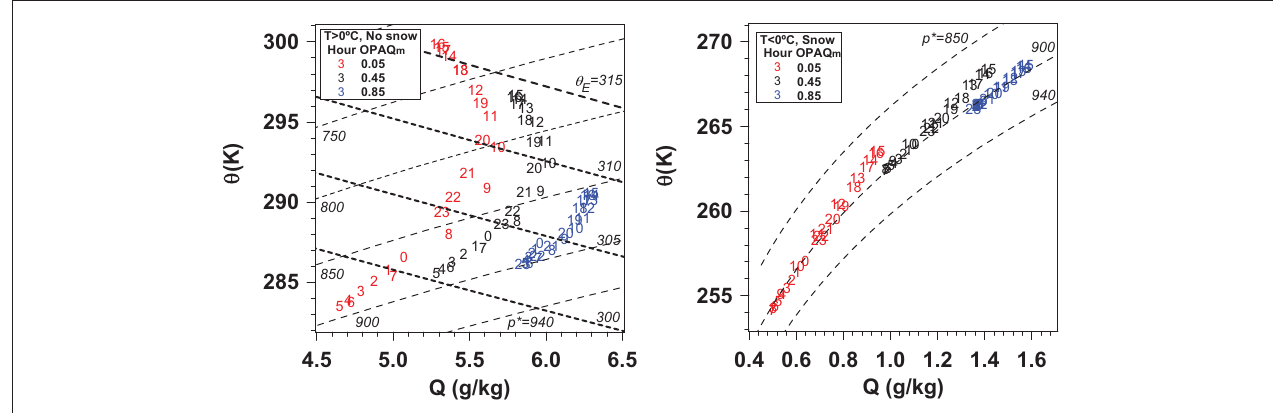
FIGURE 10 | Conserved variable plot for (left) warm season without snow and (right) cold seaason with snow for OPAQm = 0.05, 0.45, and 0.85.